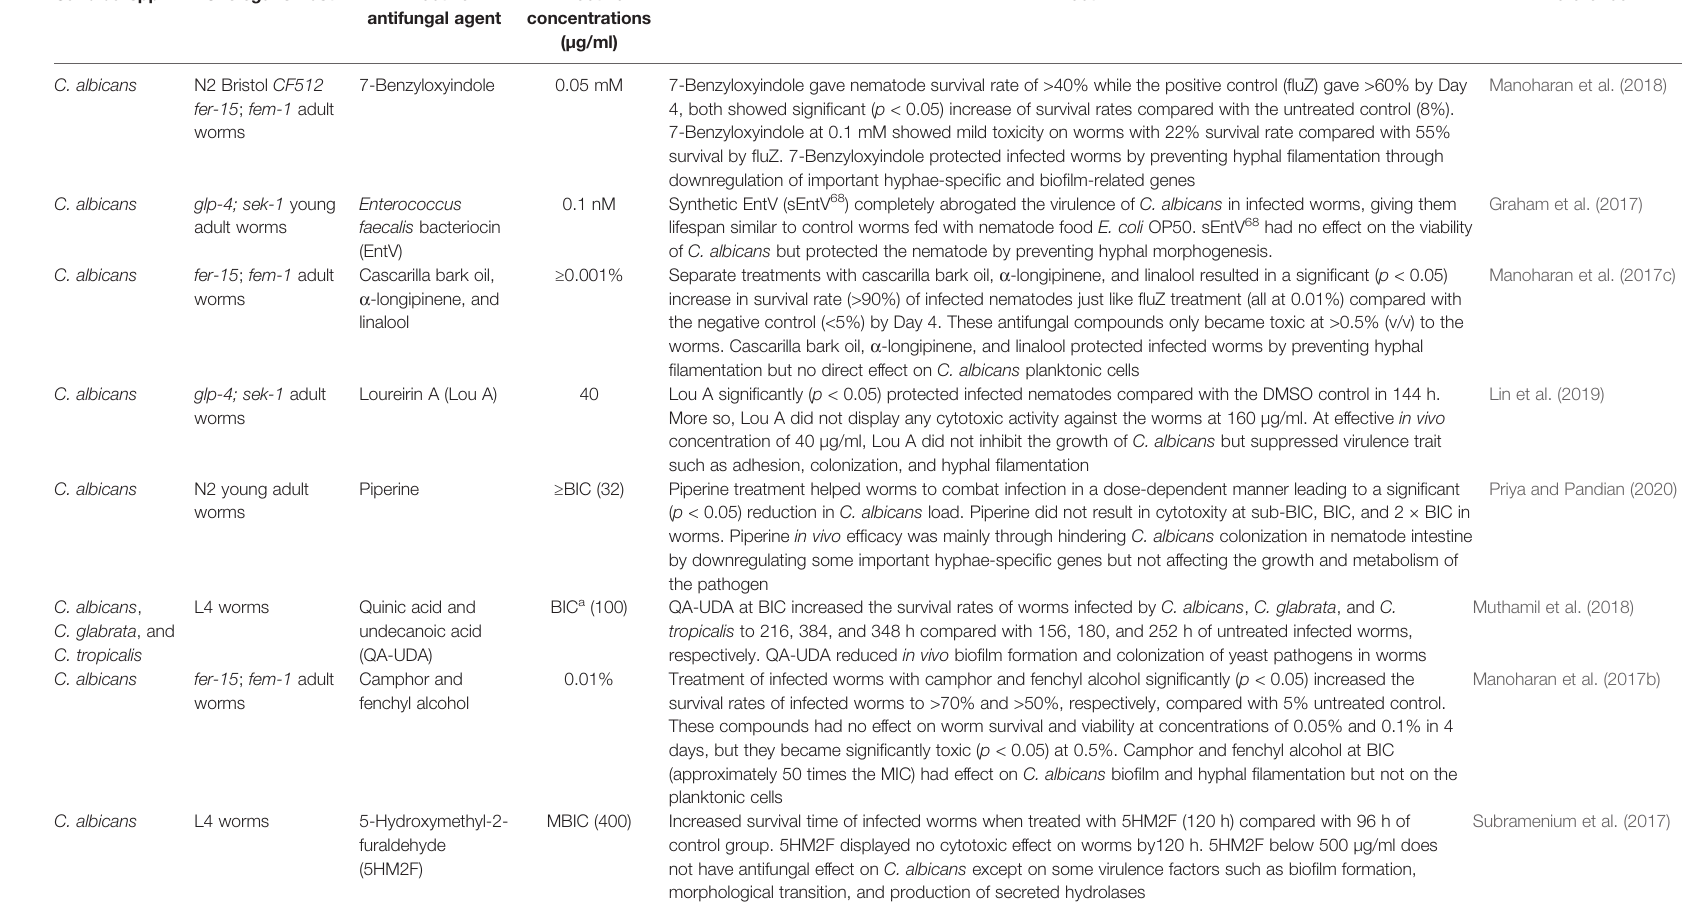
TABLE 4 | C. elegans model demonstrating alternative inhibition mechanisms against Candida species. Candida